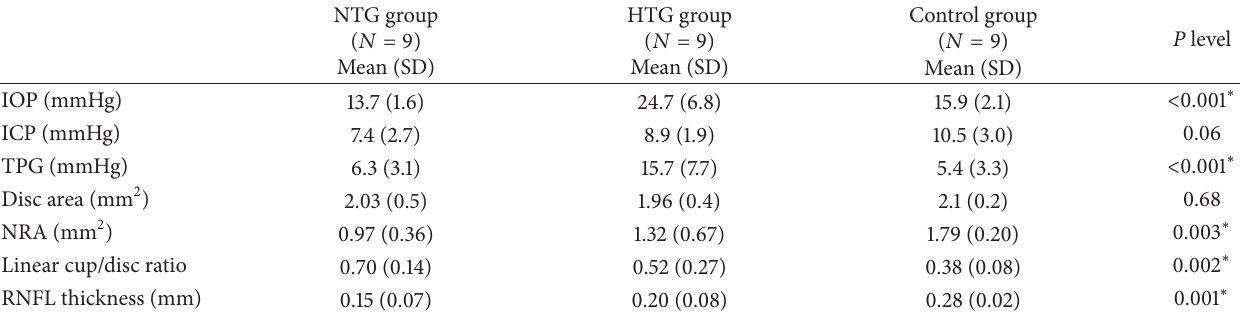
Table 2: Changes in intraocular pressure, intracranial pressure, translaminar pressure gradient, and optic nerve disc structure. NTG group